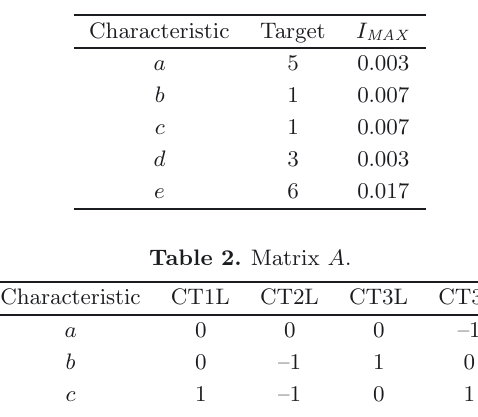
Fig. 1. Example of a workpiece to make using machining. Table 1. Inertial tolerances.